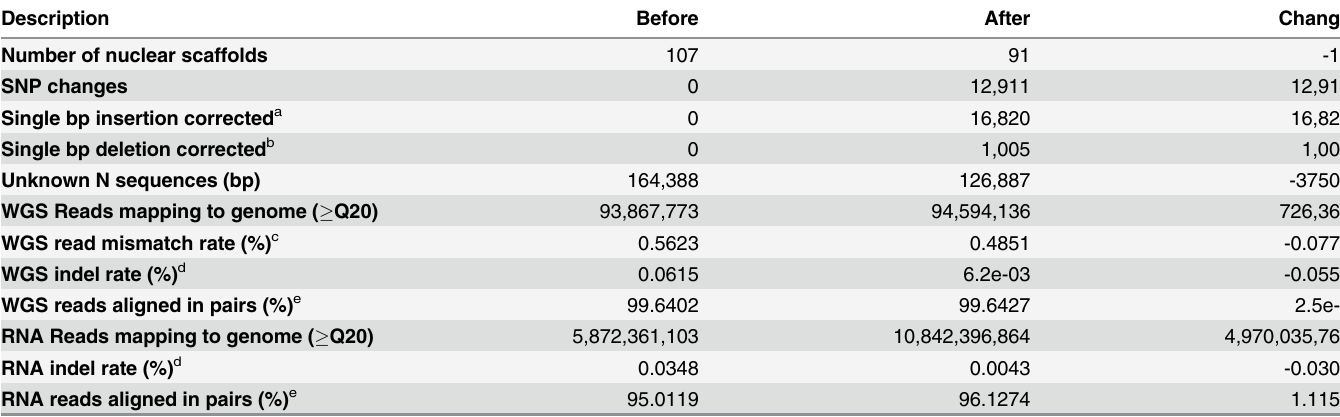
Table 1. Summary of corrections made to the P . nodorum SN15 genome